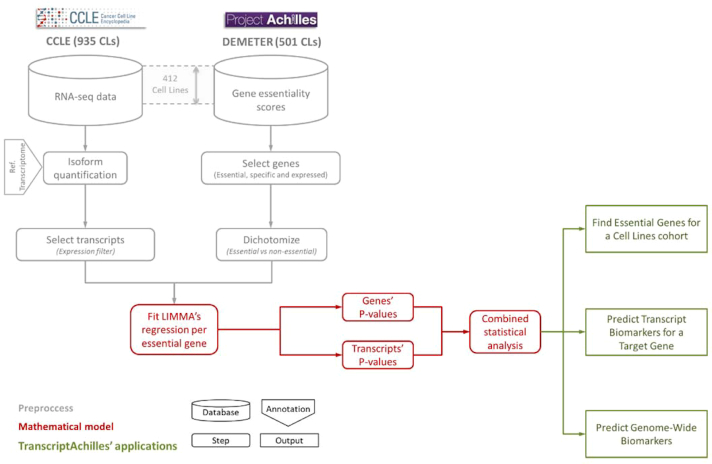
TranscriptAchilles’ workflow. Database icons represent CCLE and Project Achilles data. A total of 412 samples were matched between them. Step boxes represent algorithmic analysis, for both preprocessing (grey) and mathematical modeling (red). Green boxes represent applications of TranscriptAchilles. CL: cell line.